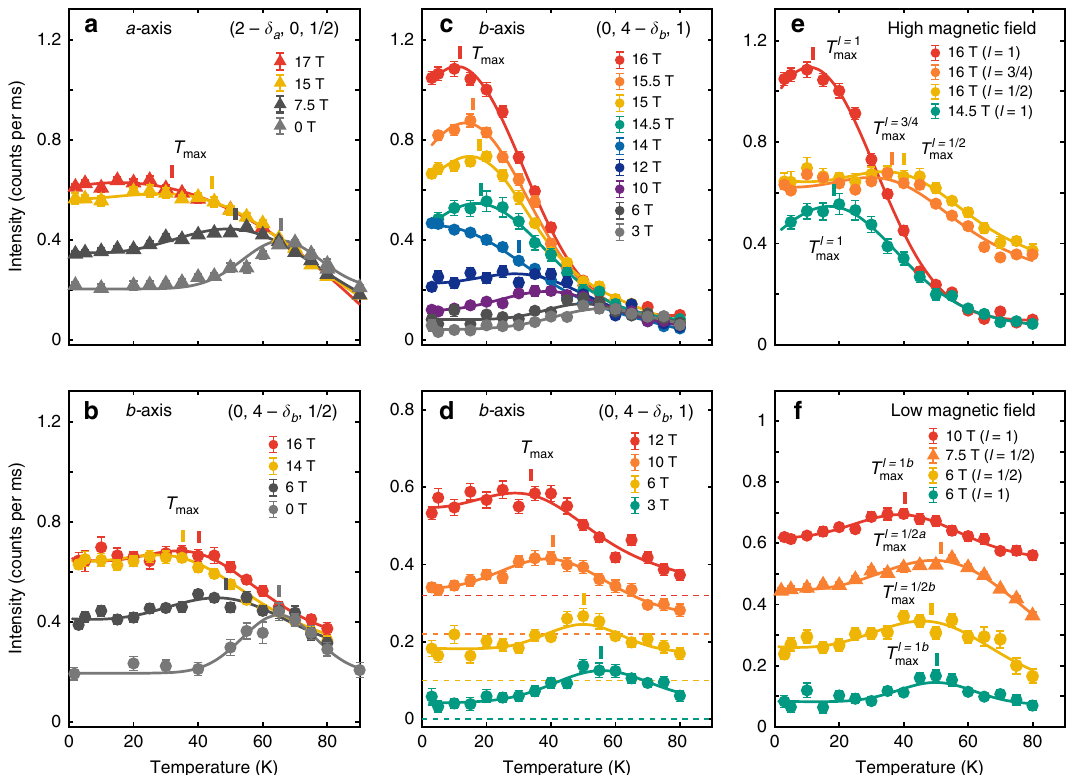
Fig. 5 Temperature scales for phase competition. a – f Peak intensities versus temperature measured at ℓ = 1 ∕ 2 and 1 charge-density-wave modulation vectors versus temperature. a , b Intensity for (2 − δ a , 0, 1 ∕ 2) and (0, 4 − δ a , 1 ∕ 2) with magnetic fi elds as indicated. Data in a and zero- fi eld data in b are re-plotted from ref. 9 . Non-zero magnetic fi eld data in b is ℓ ~ 0.6 amplitudes obtained from two-Gaussian fi ts of ℓ -scans. c Diffraction intensities at (0, 4 − δ a , 1). d Same data as in c but zoomed on the low- fi eld curves. For visibility, these curves have been given an arbitrary vertical shift – as indicated by the dashed base-lines. e , f Comparisons of ℓ = 1 and 1 ∕ 2 temperature dependencies and with that the associated maximum temperature scales T the high- and low- magnetic fi eld regimes respectively. Solid lines are fi ts to a skewed Gaussian (see text) on a linear background. Vertical bars are the T temperature scales de fi ned by the maximum of the second derivative of the skewed Gaussian. Error bars are standard deviations due to counting statistics. Source data are provided as a Source Data fi